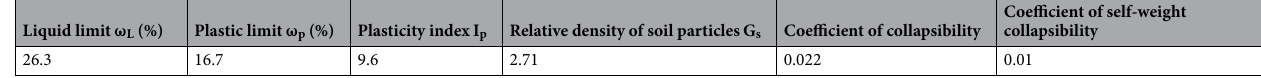
Table 1. Physical properties of loess.